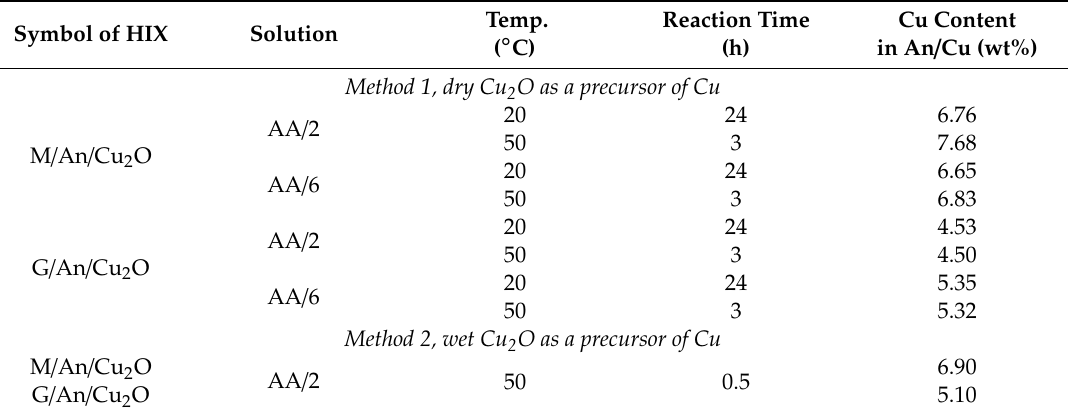
Table 3. Conditions and results of Cu 2 O